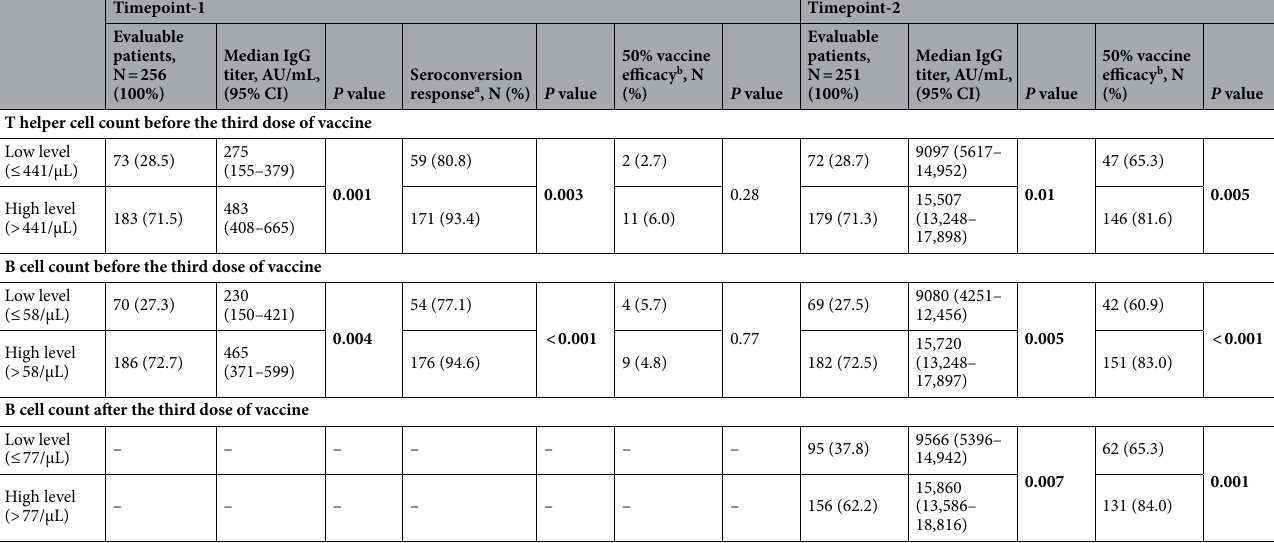
Table 2. Univariate analysis of antibody response. Statistically significant P values are highlighted in bold. Differences between groups were assessed using the Mann–Whitney U test (continuous variable) or the Pearson’s χ 2 test (categorical variables), as appropriate. A two-sided P value of < 0.05 was considered statistically significant. IgG, immunoglobulin G; AU, arbitrary unit; CI, confidence intervals. a Seroconversion response